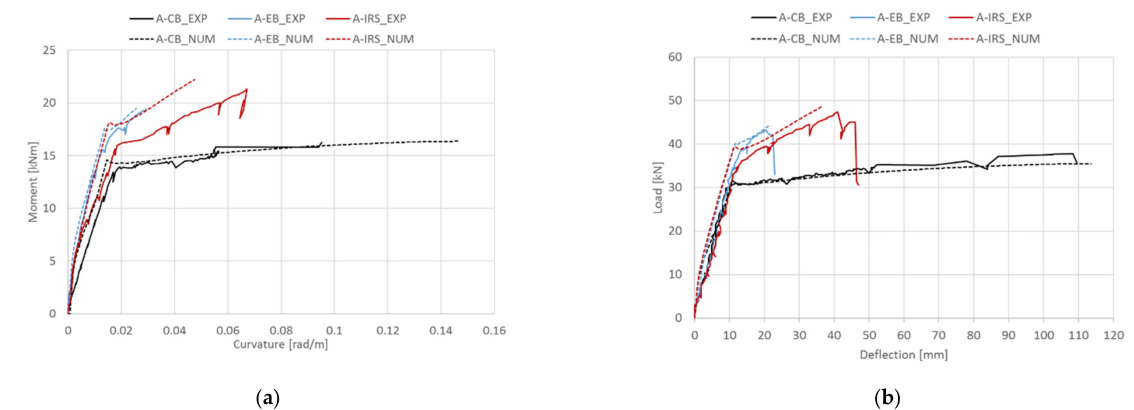
Figure 9. Experimental/theoretical comparisons (group A): ( a ) moment–curvature; ( b ) load–midspan deflection.